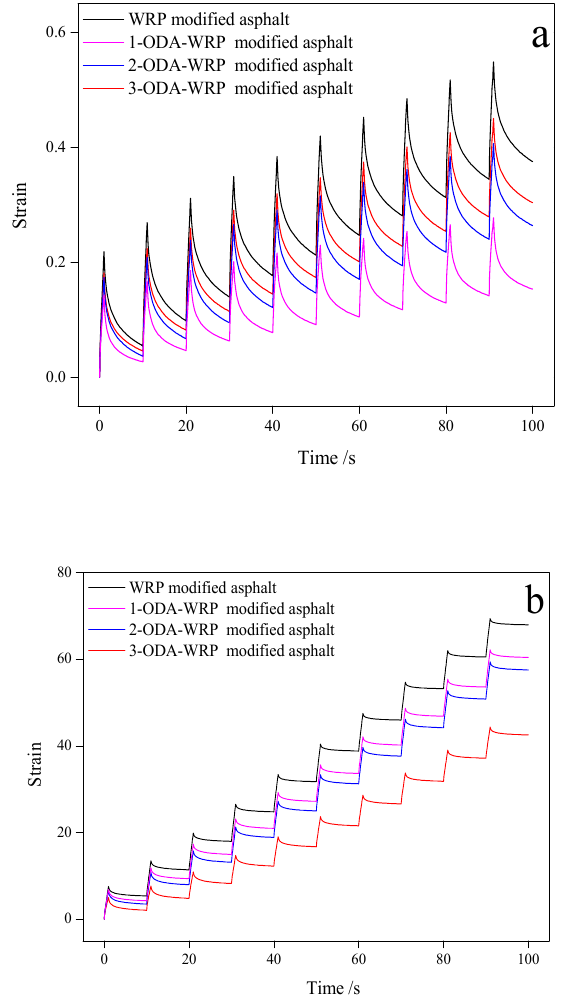
Figure 7. Time-strain relation of different asphalt samples at 82 °C under: ( a ) 0.1 KPa and ( b ) 3.2 KPa. 270